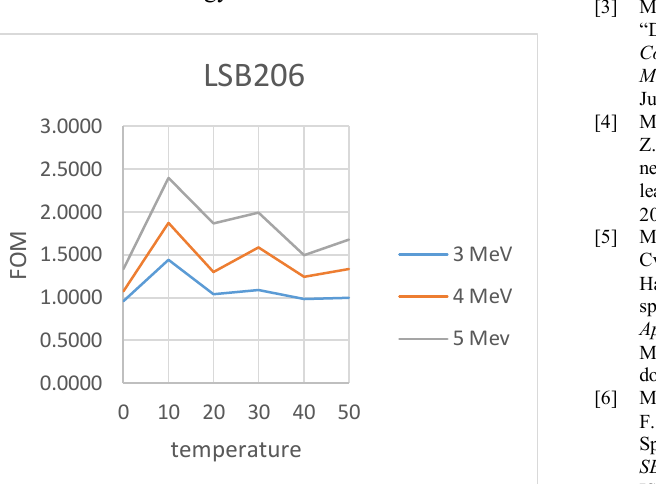
Fig. 5. FOM temperature dependence of the LSB 205 for some energy